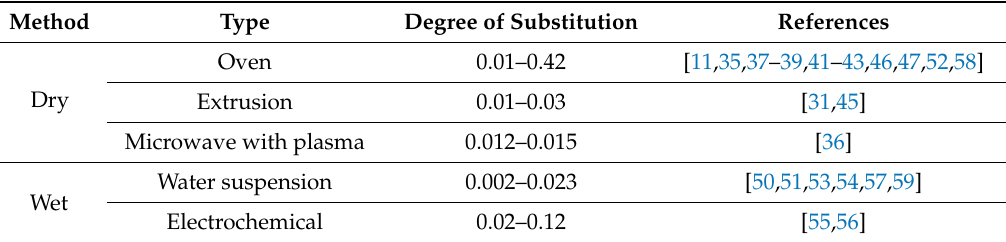
Table 1. Methods of citric starch samples